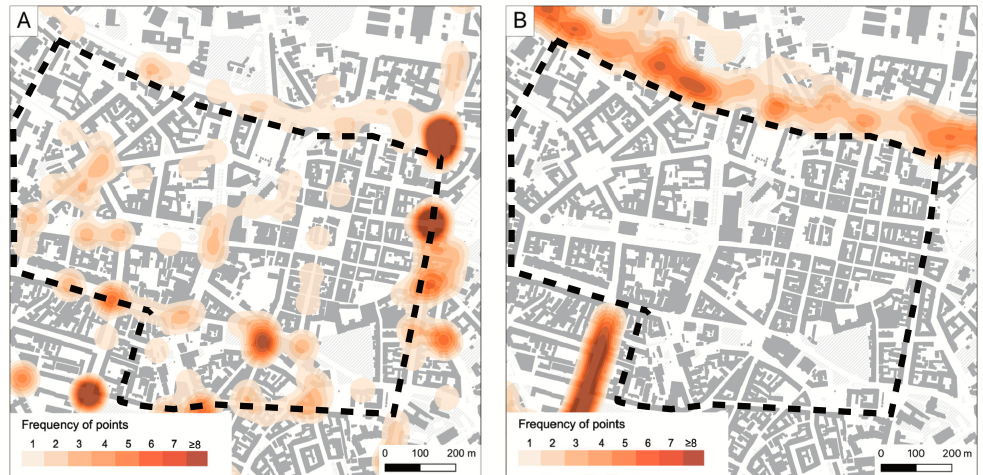
Figure 3. Comparison of places indicated by the group of residents ( A ) and urban planners ( B ) re- garding areas of lack of traffic safety—“zone 30” and surroundings. The dashed black line marks the areas of difference. Source of reference data: © OpenStreetMap contributors, see: